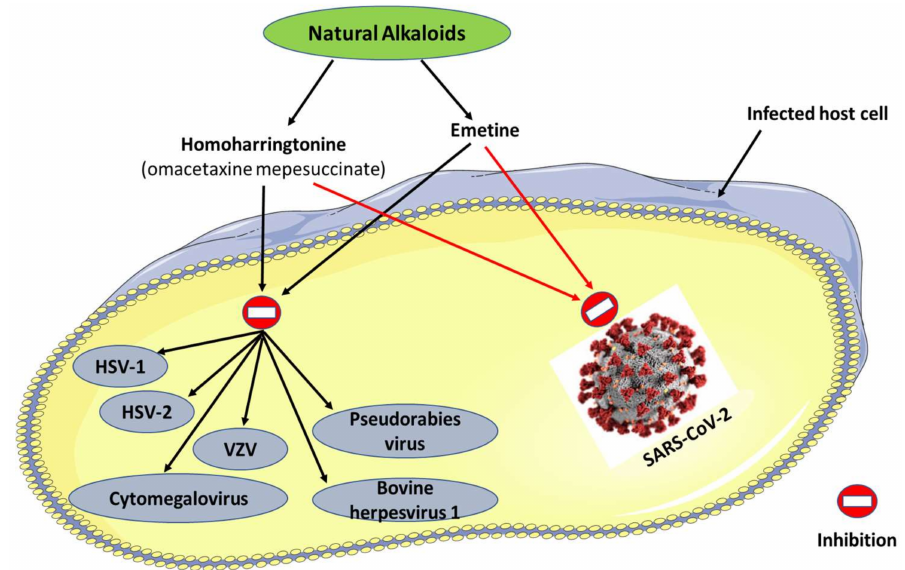
Figure 1. Natural alkaloids with dual anti-infective properties against SARS-CoV-2 and various types of herpesvirus. HSV: herpes simplex virus; VZV: varicella-zoster virus; SARS-CoV-2: Severe Acute Respiratory Syndrome